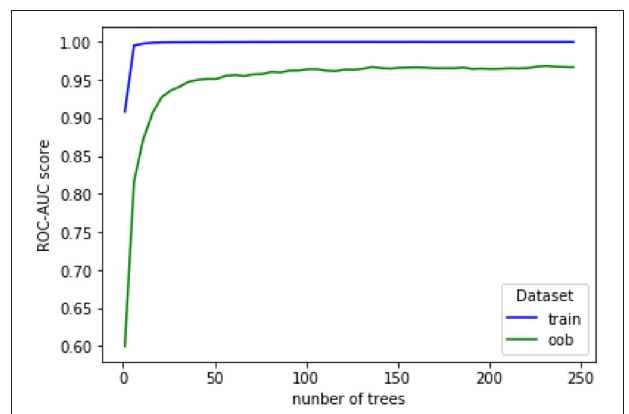
FIGURE 6 | Evolution of AUC-ROC for training and out-of-bag (oob) sets as a function of number of trees.